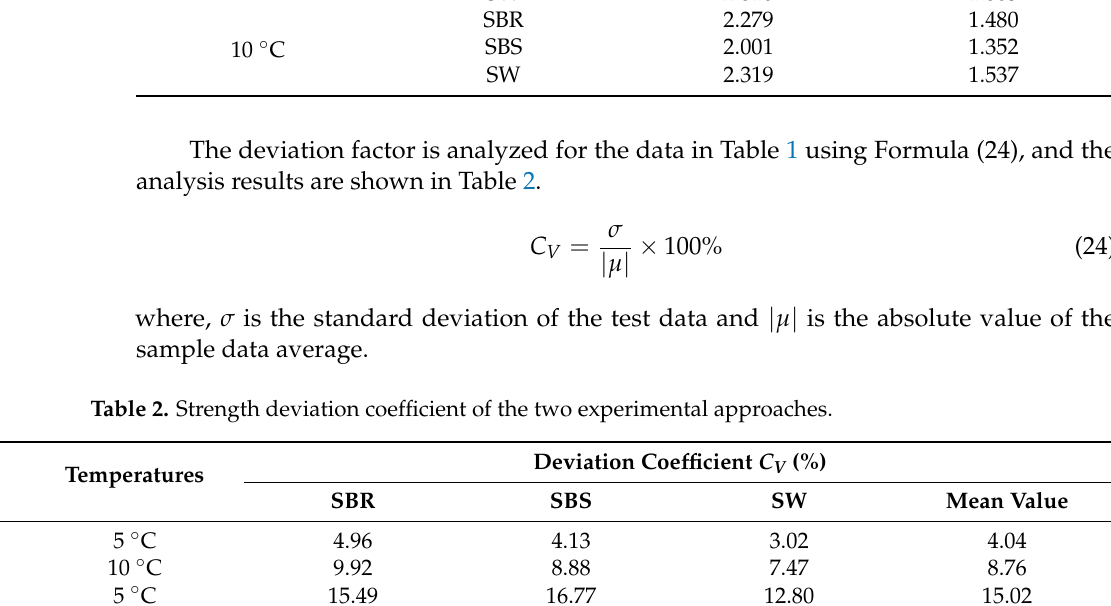
Table 1. Interlayer bond tensile strength of the indirect tensile test and the direct tensile test. Temperatures Bonding Materials 5 ◦ C